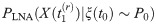
Schematic diagram of the distributions PLNA(X(t1(r))|ξ(t0)∼P0) as r increases.The yellow distribution represents the limit as r → ∞. Although, for free oscillators the latter distribution diverges, the corresponding conditional distributions on the transversal converge.